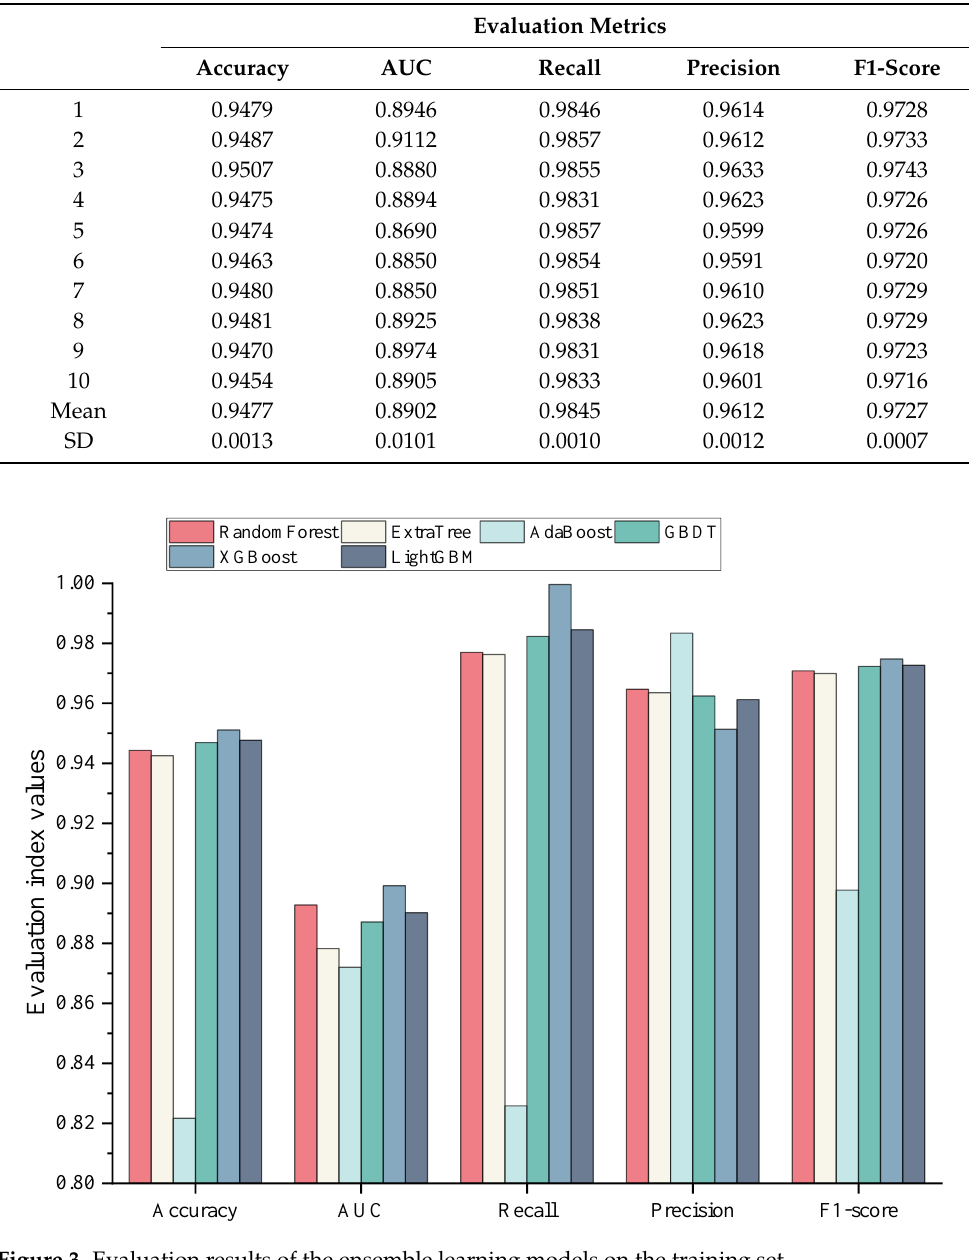
Table 10. Evaluation results on the ensemble learning model test set. Model